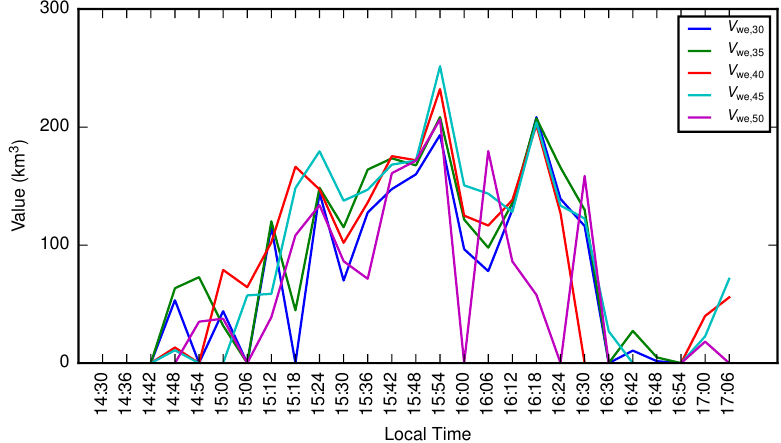
Figure 15. Changes of V we, R